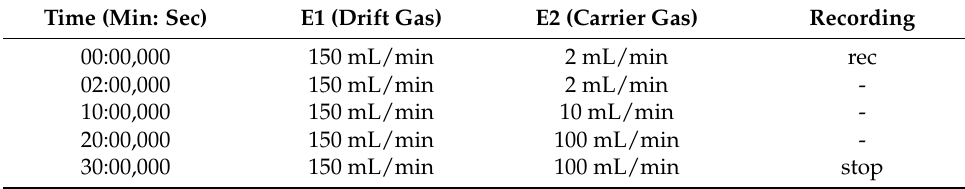
Table 2. Gas chromatography